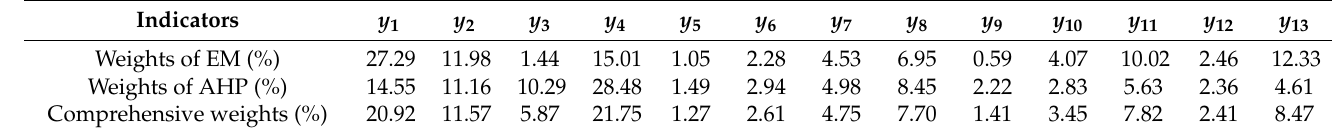
Table 3. The weights of the debris flow